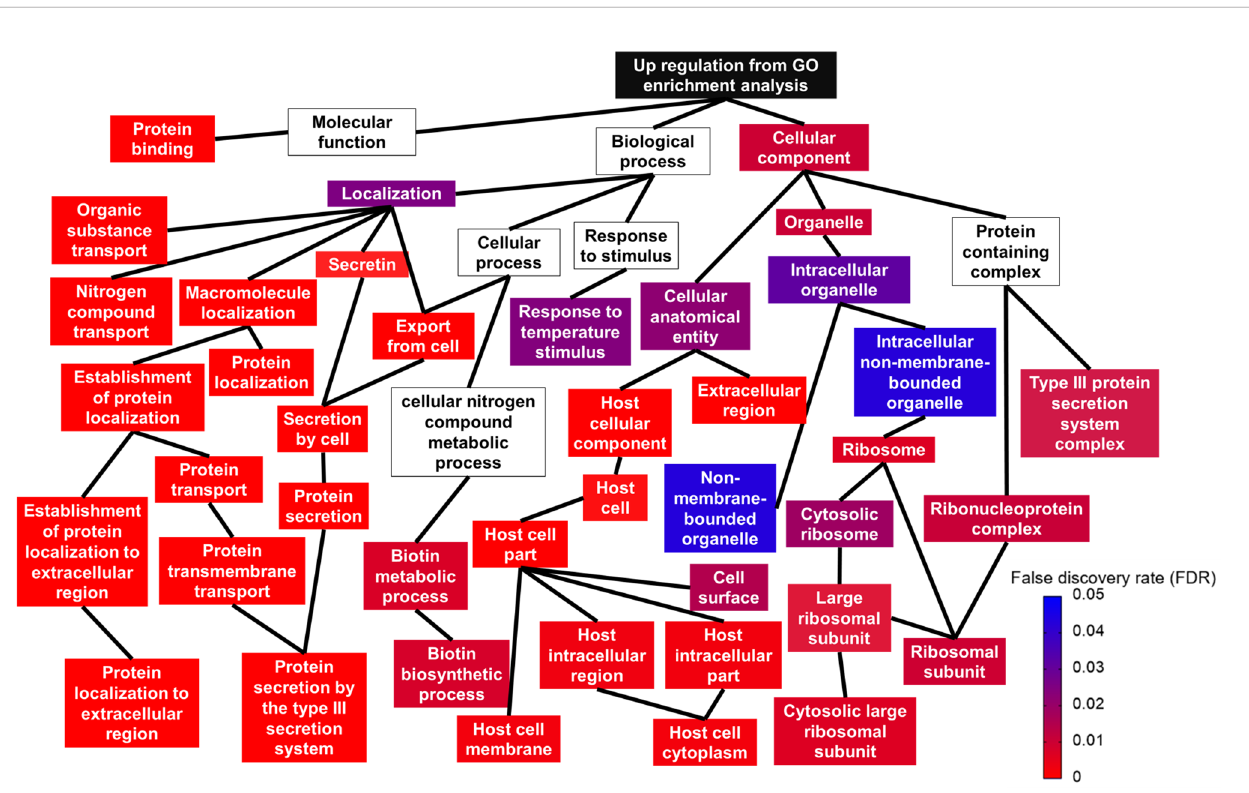
FIGURE 4 | Relationship between upregulated gene ontology (GO) terms shown in a topologic structure. Each GO term is represented by a box. The color of the box (from red to blue) is an indication of false discovery rate; a box without any color means the GO term was not signi fi